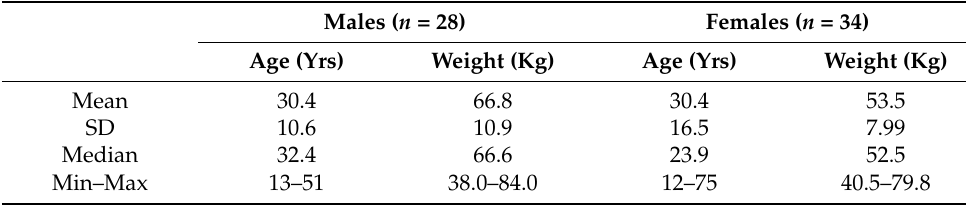
Table 1. Patients’ demographic characteristics. SD: standard